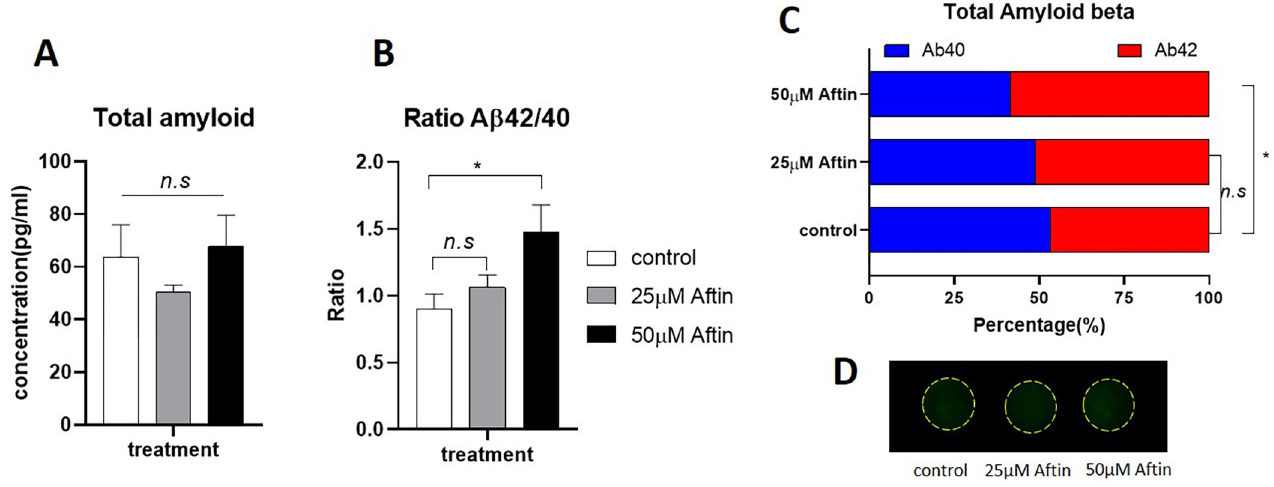
Fig 3. Small molecule-induced amyloid- β 42 production A) The concentration of total amyloid- β (40+42 isoforms) analyzed by ELISA assay. B) The ratio of total amyloid- β 42 to amyloid- β 40. C) The percentage of two isoforms in total amyloid- β . (n = 5) � : p < 0.05. n.s: not statistically different. D) A total protein of 1 μ g was blotted on nitrocellulose membrane and probed with actin- β antibody.